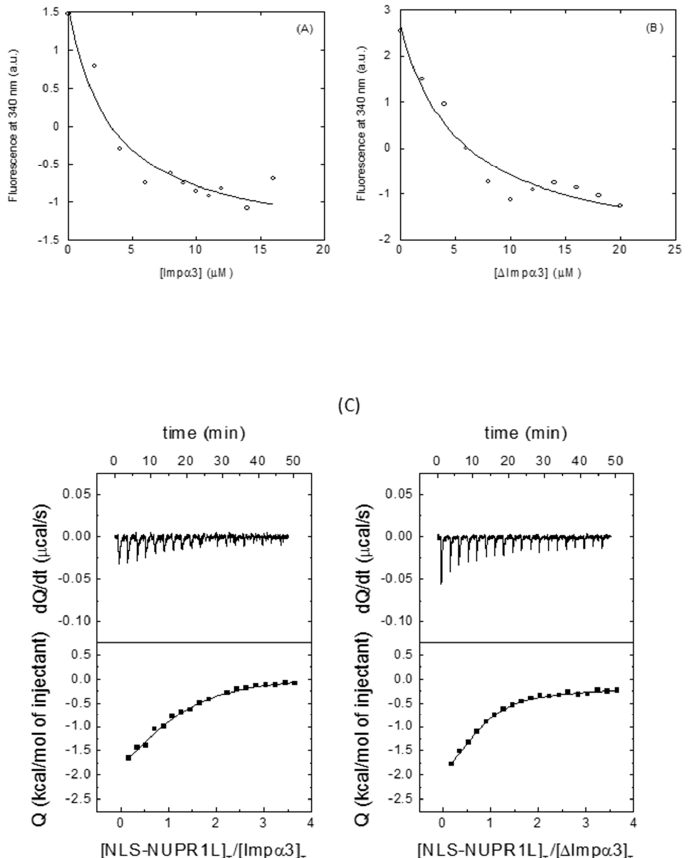
Figure 4. Binding of NLS-NUNPR1L to both importin species: ( A ) Titration curve monitoring the changes of Imp α 3 fluorescence at 340 nm in the presence of NLS-NUPR1L, after excitation at 280 nm. ( B ) Titration curve monitoring the changes of ∆ Imp α 3 fluorescence at 340 nm in the presence of NLS-NUPR1L, after excitation at 280 nm. All experiments were carried out in phosphate bu ff er (50 mM, pH 7.0). ( C ) Calorimetric binding isotherms (ligand normalized heat e ff ect per injection as a function of the ligand / protein molar ratio) for the interaction of NLS-NUPR1L with Imp α 3 (left) and ∆ Imp α 3 (right) are shown, with the thermogram (raw thermal power data as a function of time) at the top of each panel. Binding parameters were estimated by non-linear least squares regression data analysis of the interaction isotherms applying a single ligand binding site model implemented in Origin 7.0. (OriginLab, Northampton, MA,